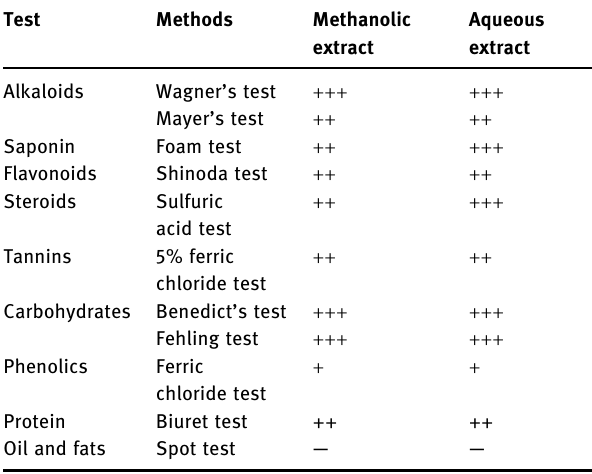
Table 3: Phytochemical composition of methanolic and aqueous root extracts of P.